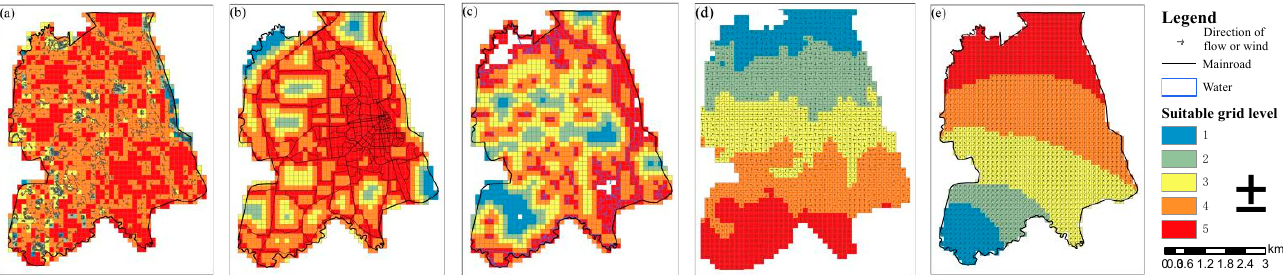
Figure 5. Reclassified results: ( a ) reclassified slope map; ( b ) reclassified roads buffer zone map; ( c ) reclassified river buffer zone map; ( d ) reclassified flow direction map; ( e ) reclassified wind direction map.